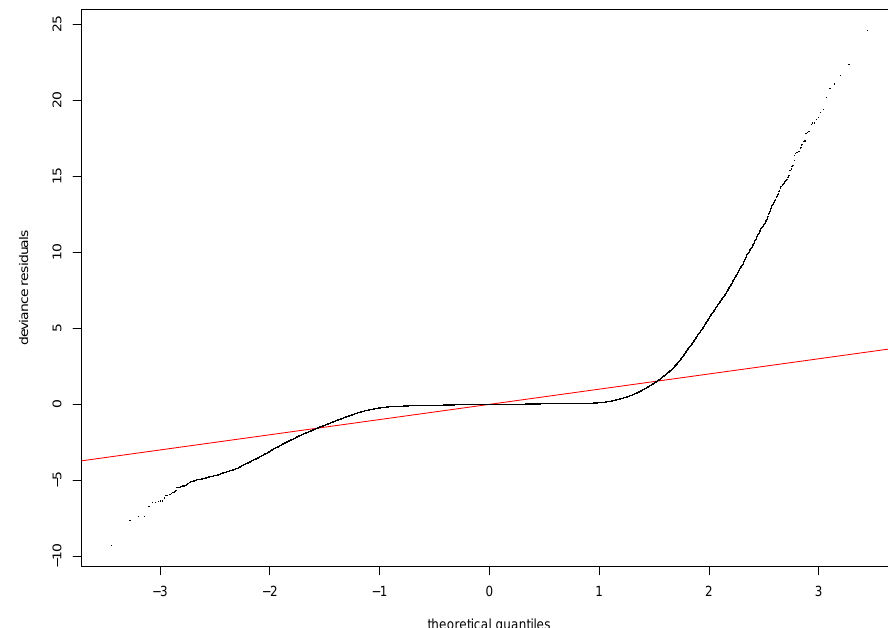
Figure A6. GAM Model Diagnostics